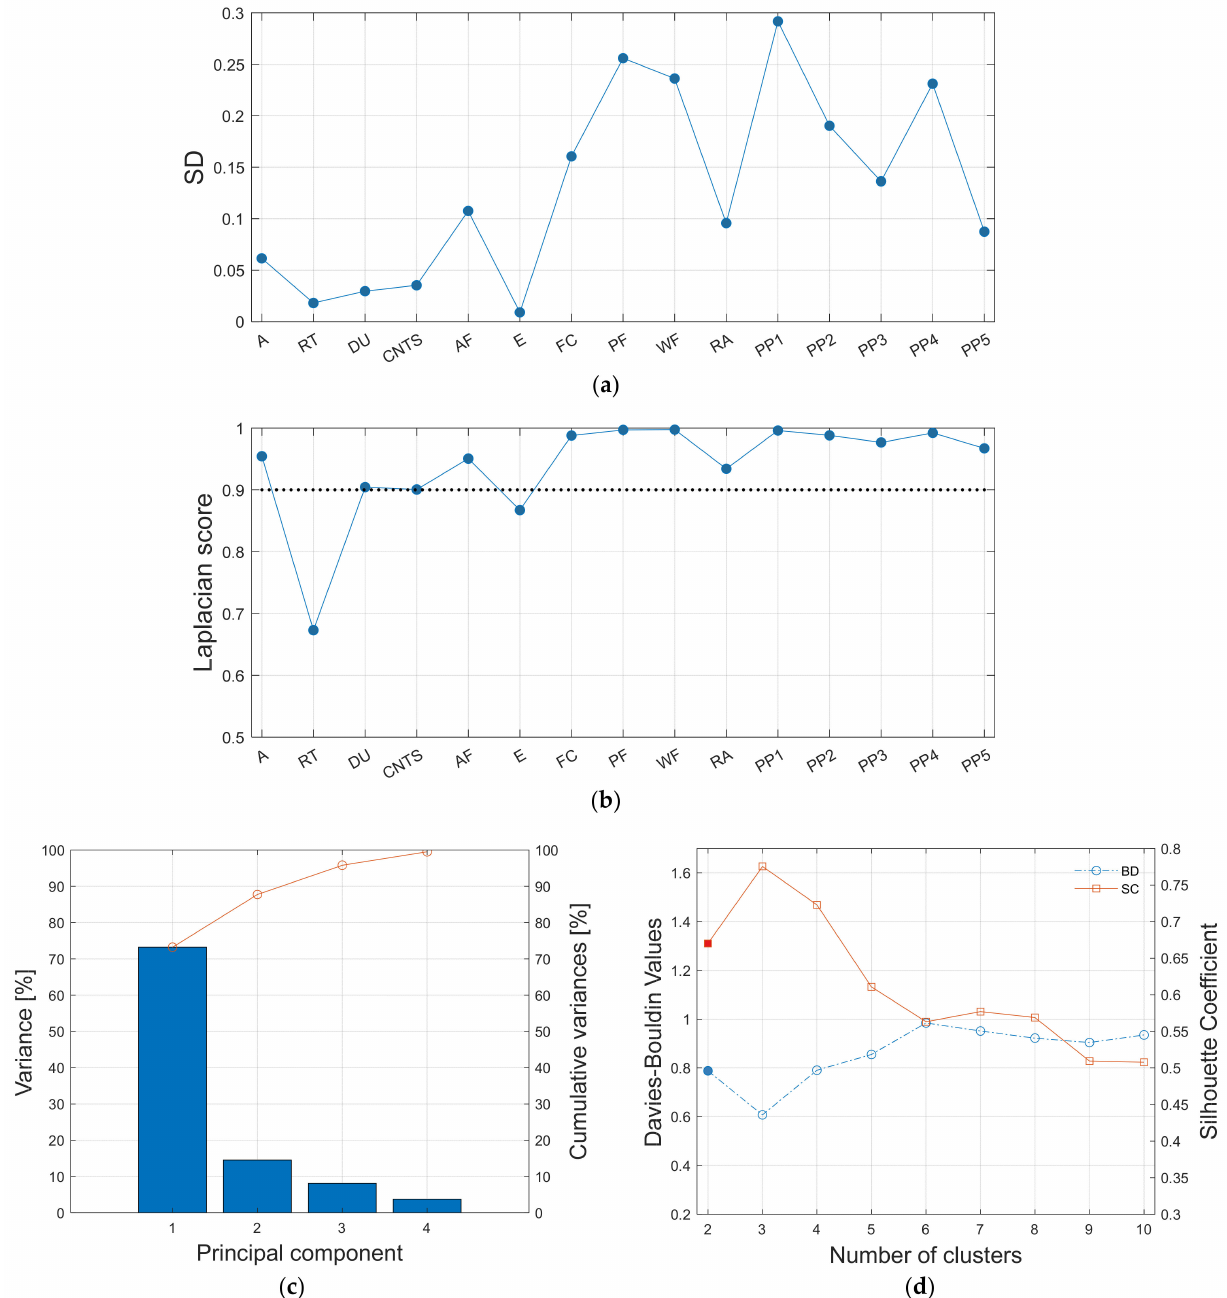
Figure 15. Different steps of the adopted unsupervised learning method (shown for AE data of sample 1): ( a ) Standard deviation of features, ( b ) feature selection using Laplacian scores, ( c ) screen plot obtained from PCA analysis, and ( d ) selection of the optimal number of clusters for k-means using cluster validity indices, i.e., Davies–Bouldin (DB) index and Silhouette Coefficient